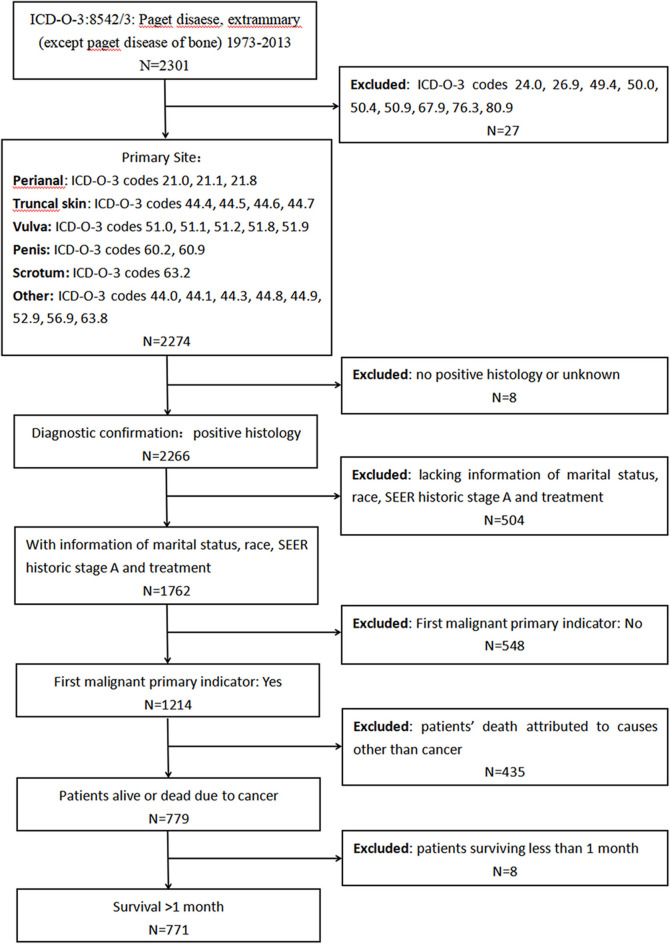
Screening process for the data from the Surveillance, Epidemiology, and End Results (SEER) program.